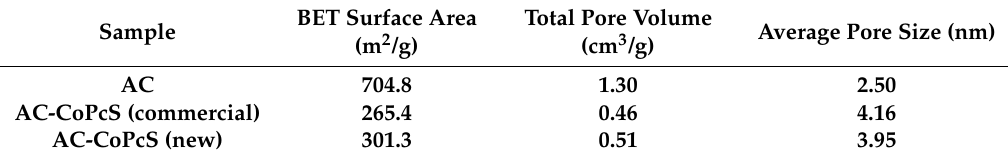
Table 1. The surface area test results of the AC, commercial, and newly prepared AC-CoPcS catalysts.